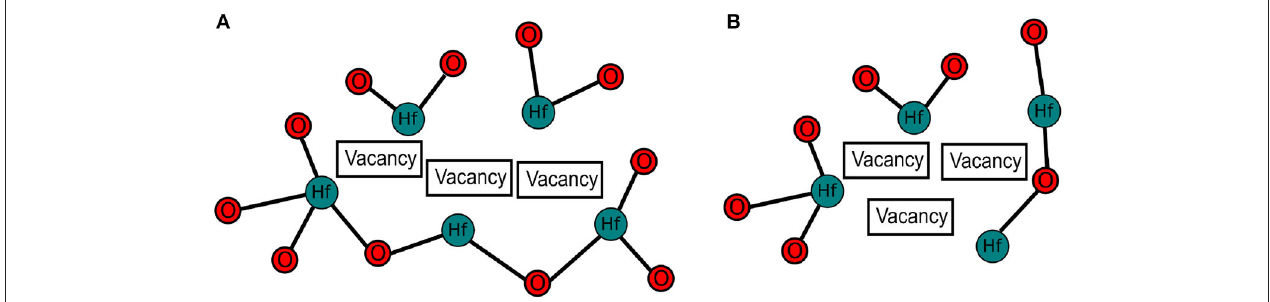
FIGURE 5 | Schematic of the two types of oxygen tri-vacancy in a-HfO 2 . (A) shows the the linear type of configuration. (B) shows the triangular type of configuration. On average, triangular type tri-vacancies are lower in energy.